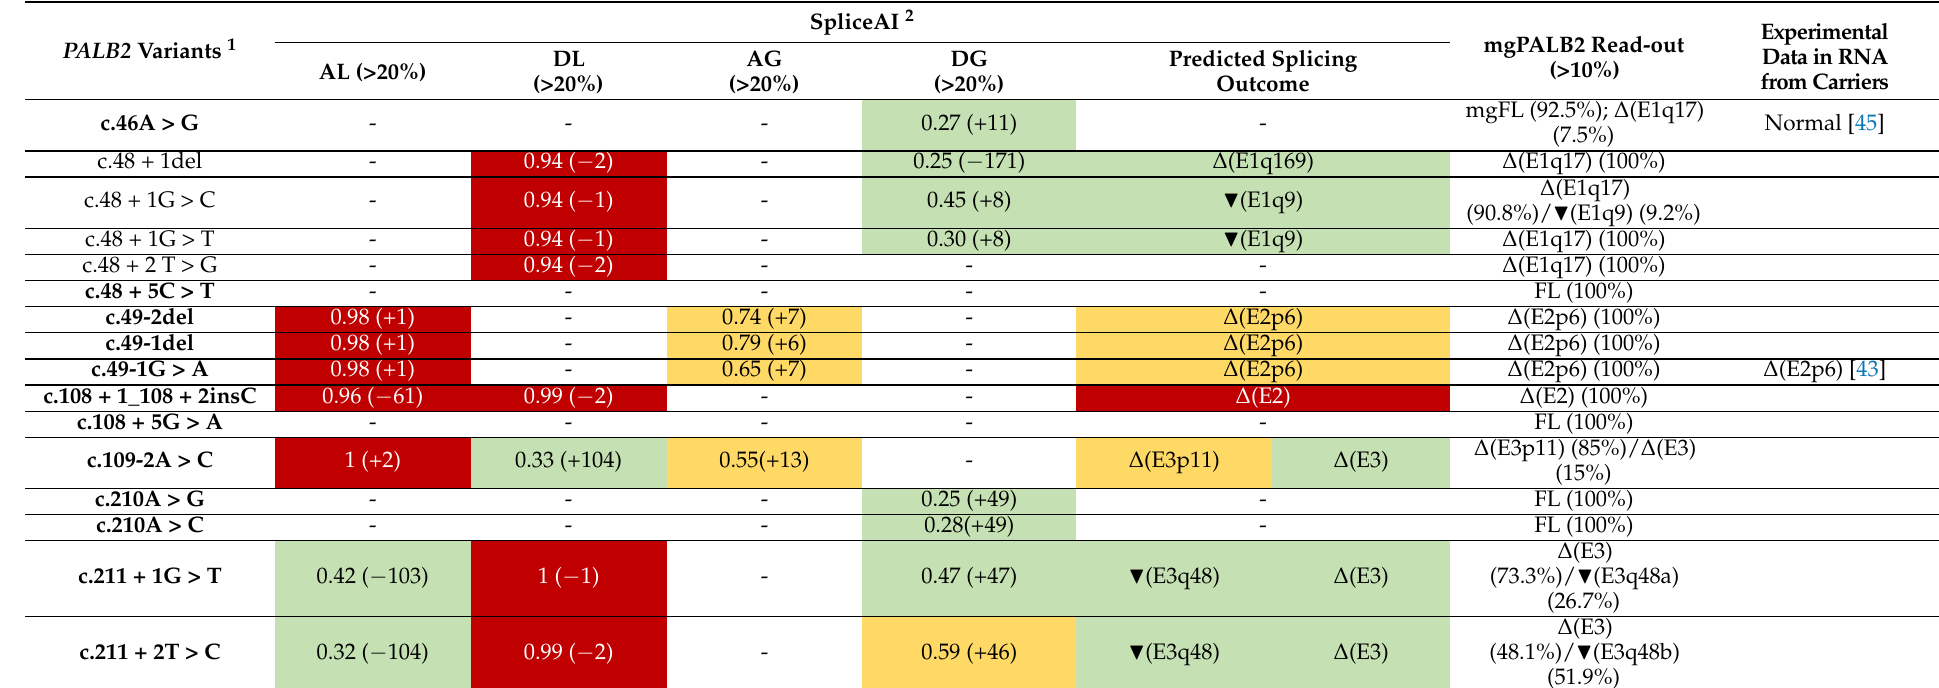
Table 3. SpliceAI predictions, mgPALB2 read-outs, and experimental splicing data in